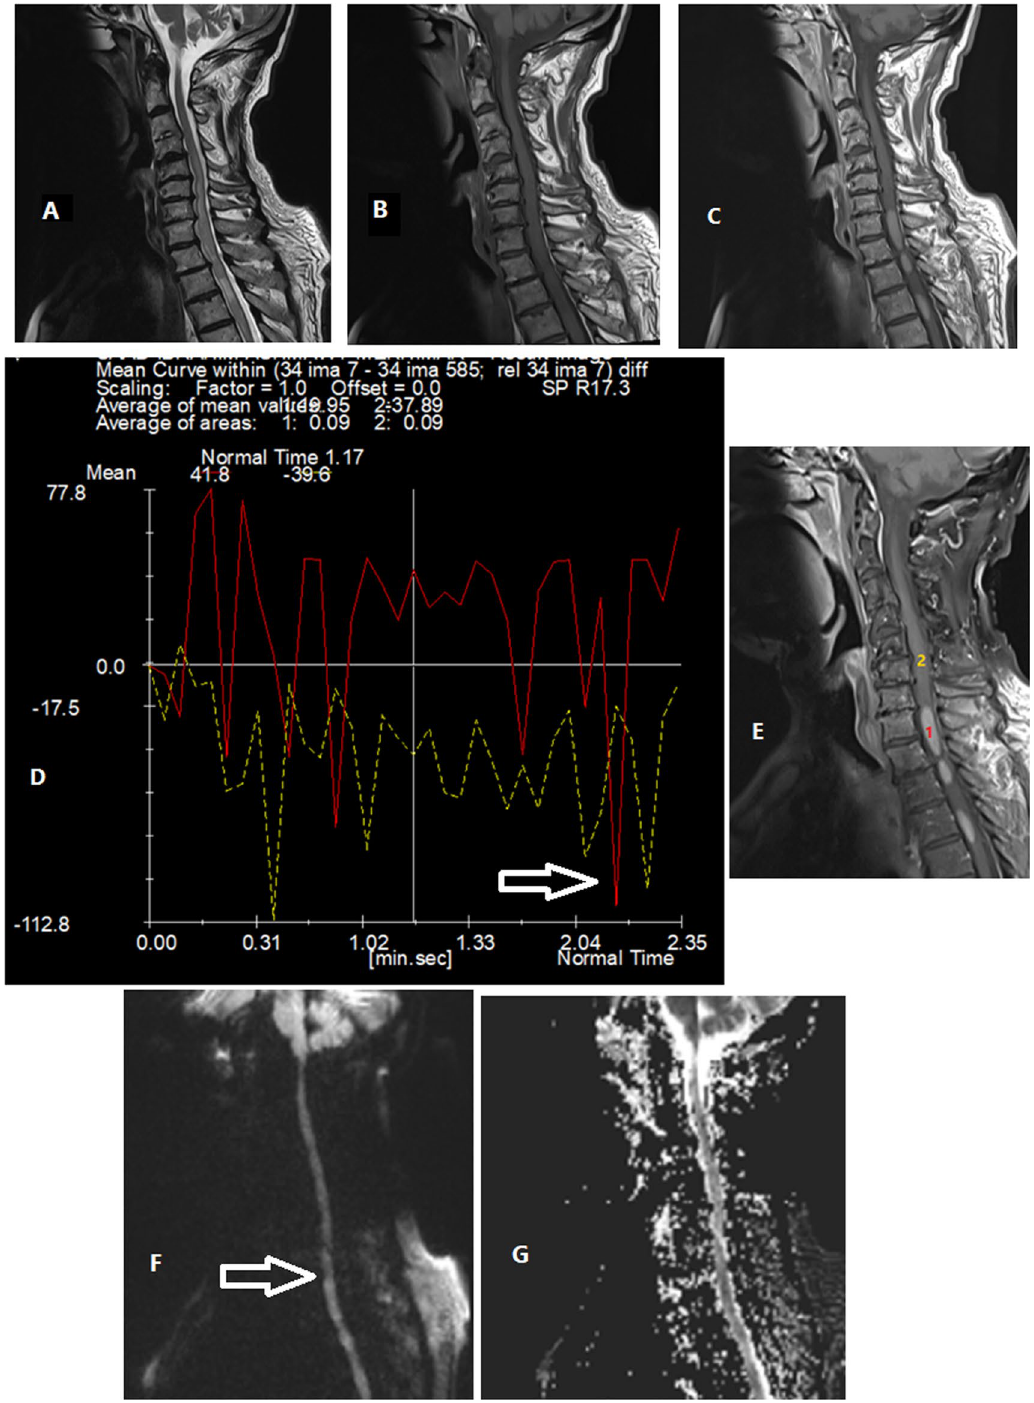
Fig. 6 71-year-old male presented with bilateral lower limb weakness and tingling sensation. T2 sagittal cervico-dorsal spine ( A ) shows interrupted areas of high signal intensity involving the cord opposite lower cervical and upper dorsal vertebrae. Pre-contrast T1 ( B ) and post-contrast T1 ( C ) show homogenous post-contrast enhancement. D and E rCBV was calculated in comparison to normal cord (yellow curve) and the curve shows hypo perfusion of the lesion (arrow to red curve). DWI at b value 1000 ( F ) shows no areas of high signal intensity within cord at site of lesions = (arrow) which appears also at ADC map ( G ) denoting free diffusion. This lesion was diagnosed as Para neoplastic